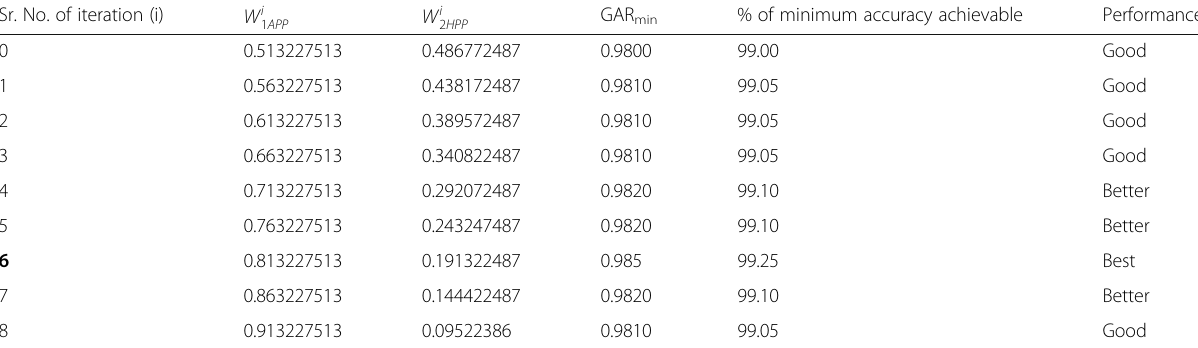
Table 2 Summary of parameters at different iterations for our acquired database Sr. No. of iteration (i)